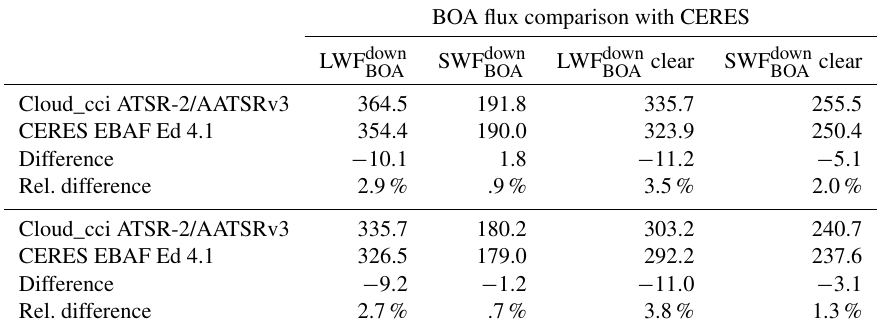
BOA flux comparison with